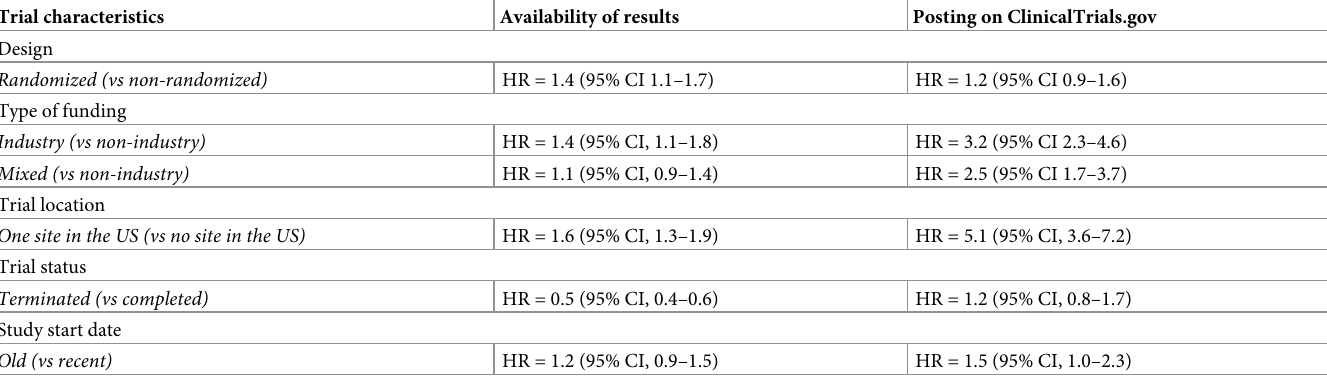
Table 3. Trial characteristics associated with results availability and posting on ClinicalTrials.gov in multivariate analysis. Trial characteristics Availability of results Posting on